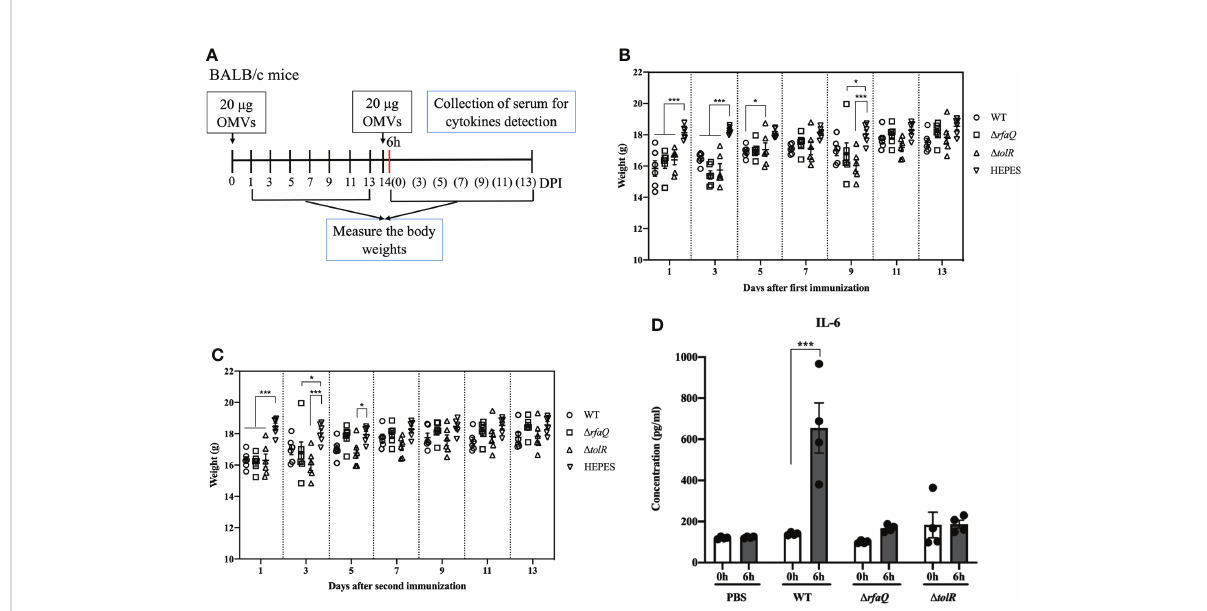
FIGURE 2 Assessment of the safety of OMVs on mouse growth. (A) Design of the animal experiment to assess the safety of OMVs (B) Body weights of mice after the fi rst immunization with OMVs. (C) Growth of mice after the second immunization with OMVs. (D) IL-6 levels in mouse sera at 6 h after immunization with OMVs from the WT, D rfaQ and D tolR strains. Data are expressed as mean ± SEM. * p ≤ 0.05; *** p ≤